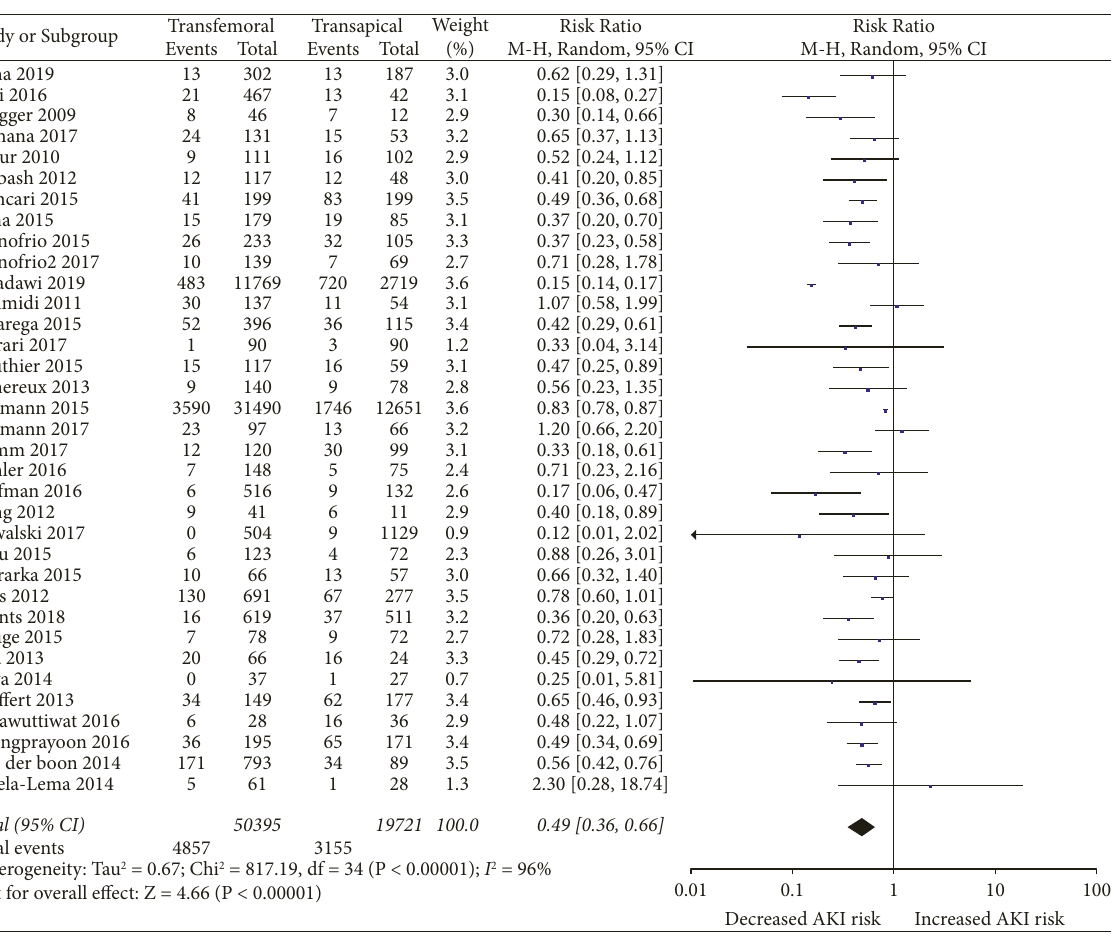
Figure 2: Forest plot comparing the risk of developing AKI between TF and TA TAVR approaches.